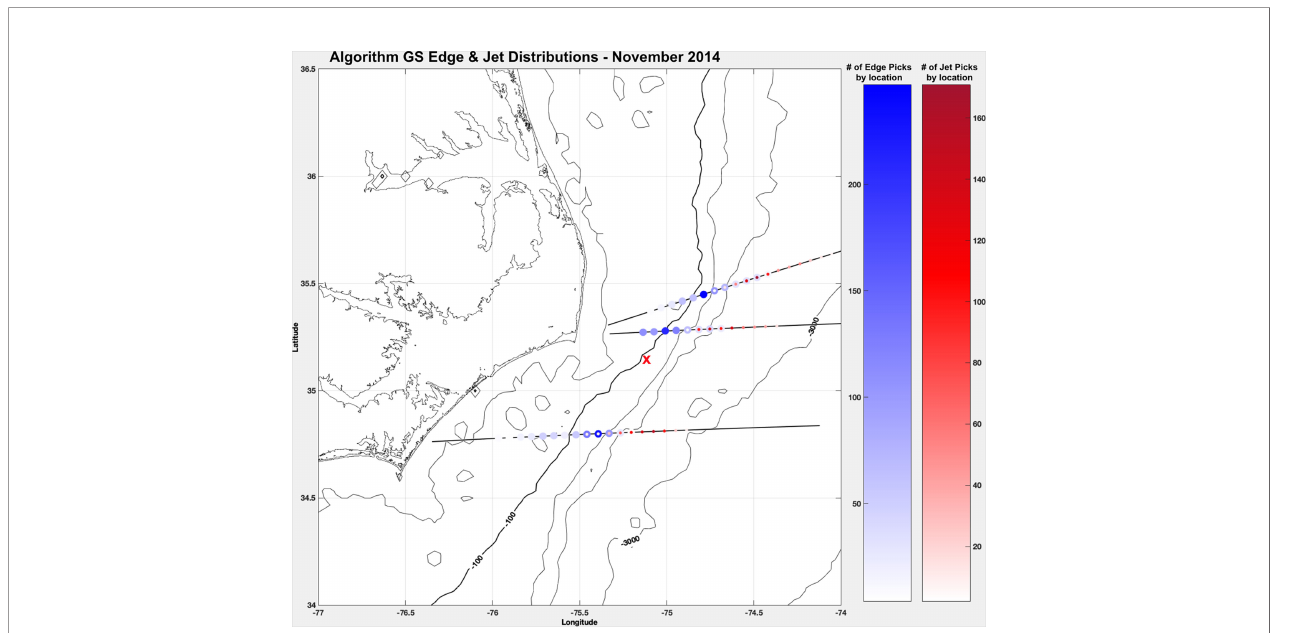
FIGURE 4 | The GS edge and jet location distributions from the algorithm for select CORE and HATY bearings during November 2014. The edge (jet) distributions are shown with blue (red) colorscale. The ADCP is located at the red ‘ x ’